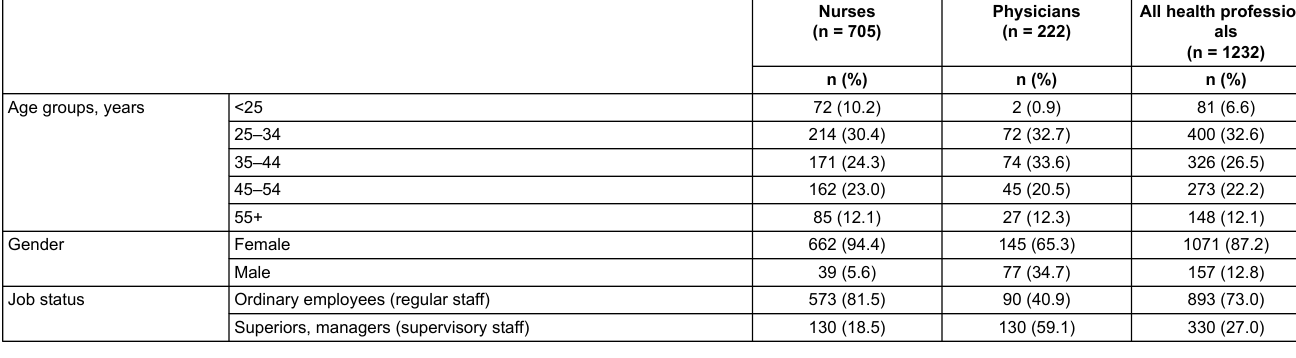
Table 1: Demographic characteristics of all health professionals and among nurses and